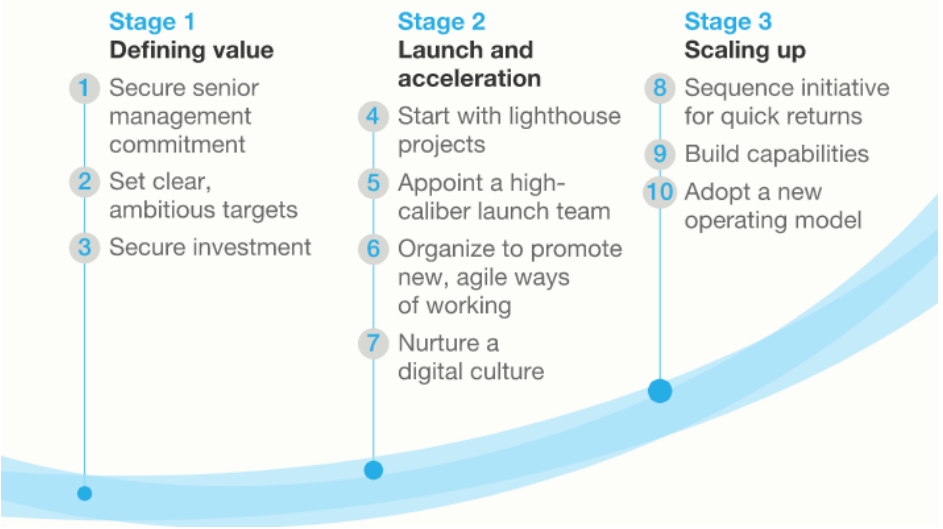
Figure 9. Ten guiding principles of digital transformation